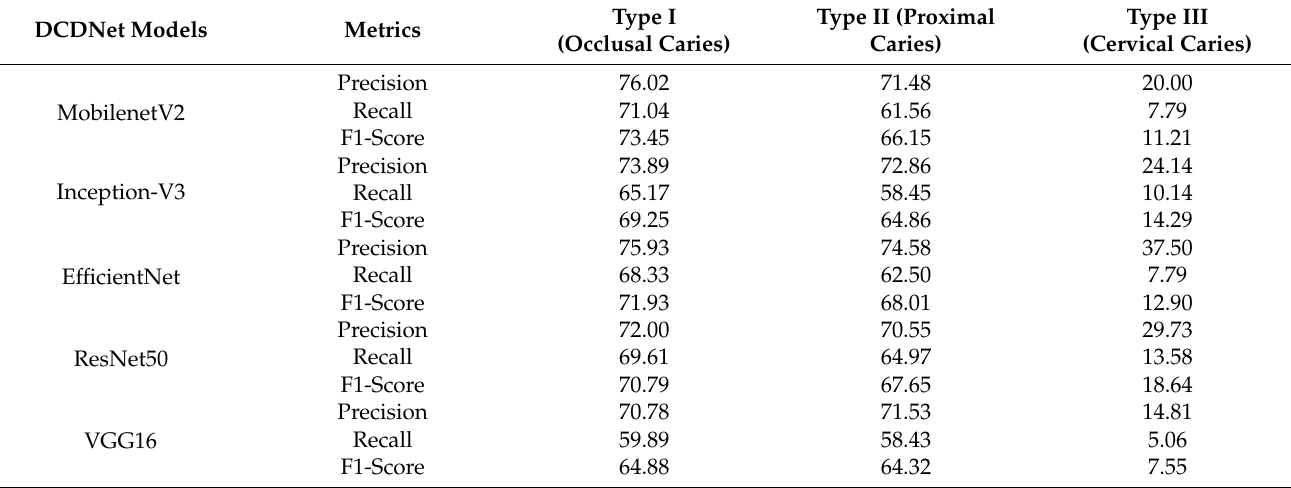
Table 4. Detailed results of the proposed models for Type I, Type II and Type III.